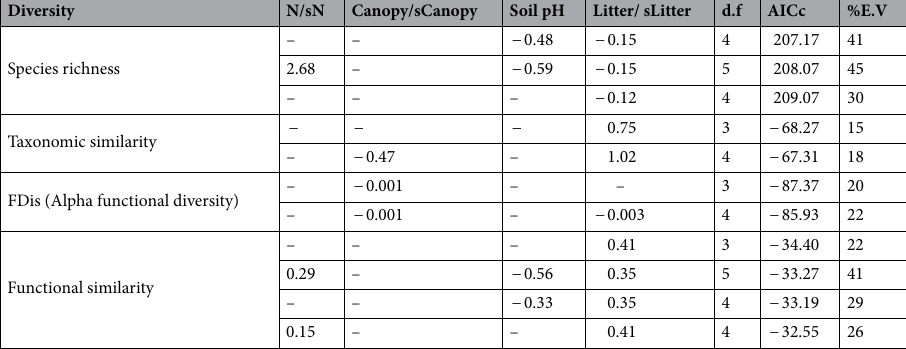
Table 1. Summary of different models that variation of diversity indices in eucalypt chronosequence in the Mesopotamic Pampa. Best models (with ΔAICc < 2) are considered those that present similar statistical support. d.f.: degree of freedom, AICc, %E.V. = percent of explained variability of each model; pseudo R 2 was used for beta taxonomic and functional diversity, and adjusted R 2 for alpha functional diversity. For GLM with negative binomial distribution, we calculated the explained variability of each model as the ratio: (null deviance-residual deviance)/null deviance. sN = similarity in nitrogen content, sCanopy = similarity in canopy cover, sLitter = similarity in leaf litter